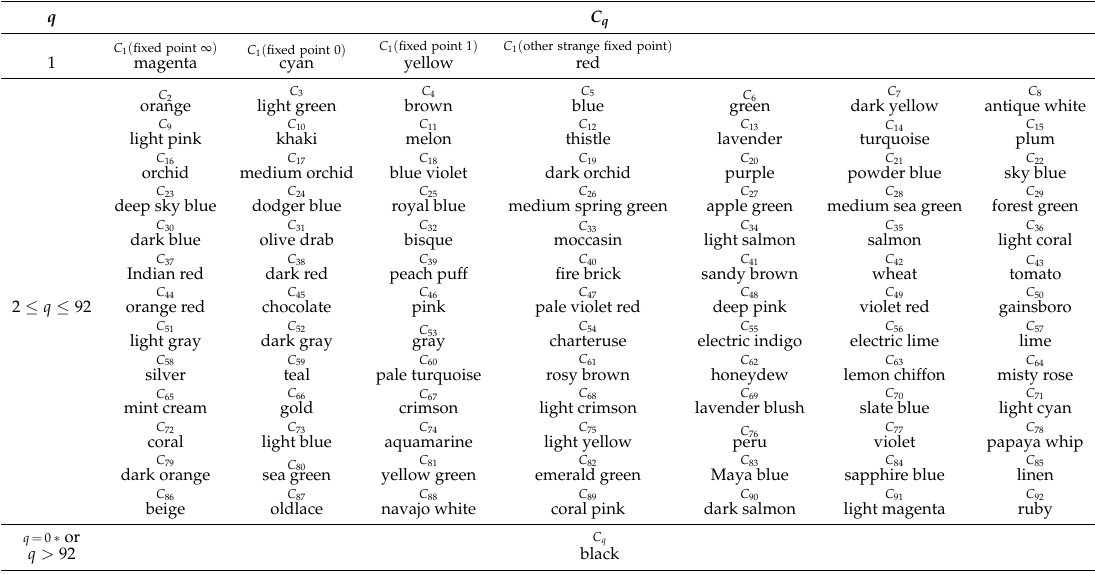
Table 1. Coloring scheme for a q -periodic orbit with q ∈ N ∪ { 0 } . q C q 1